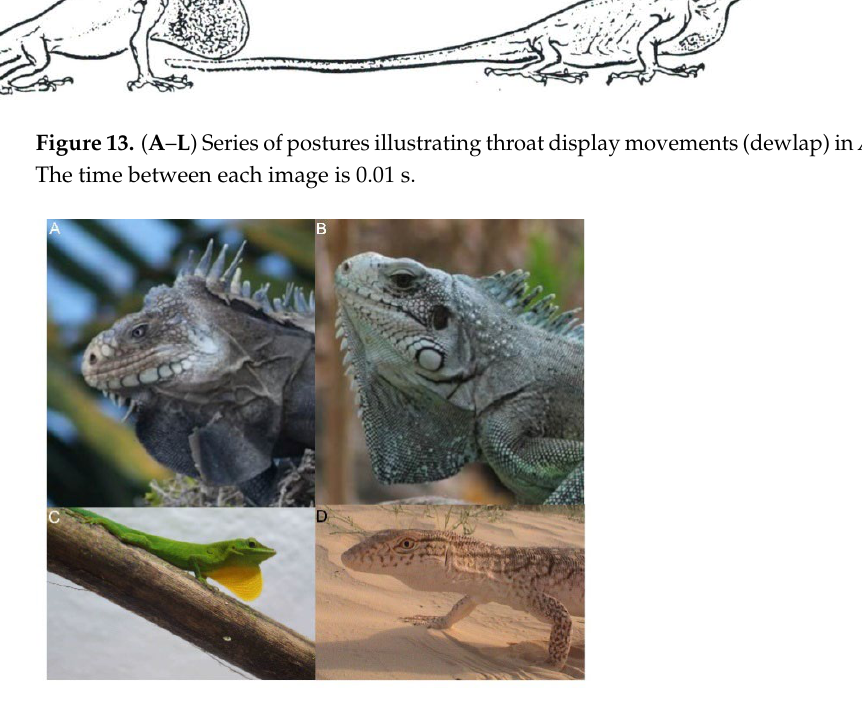
Figure 14. Examples of throat displays in lizards. ( A ) Iguana delicatissima (Archipelago of Guade- loupe). ( B ) Iguana iguana (Archipelago of Guadeloupe). ( C ) Anolis marmoratus . ( D ) Varanus griseus .